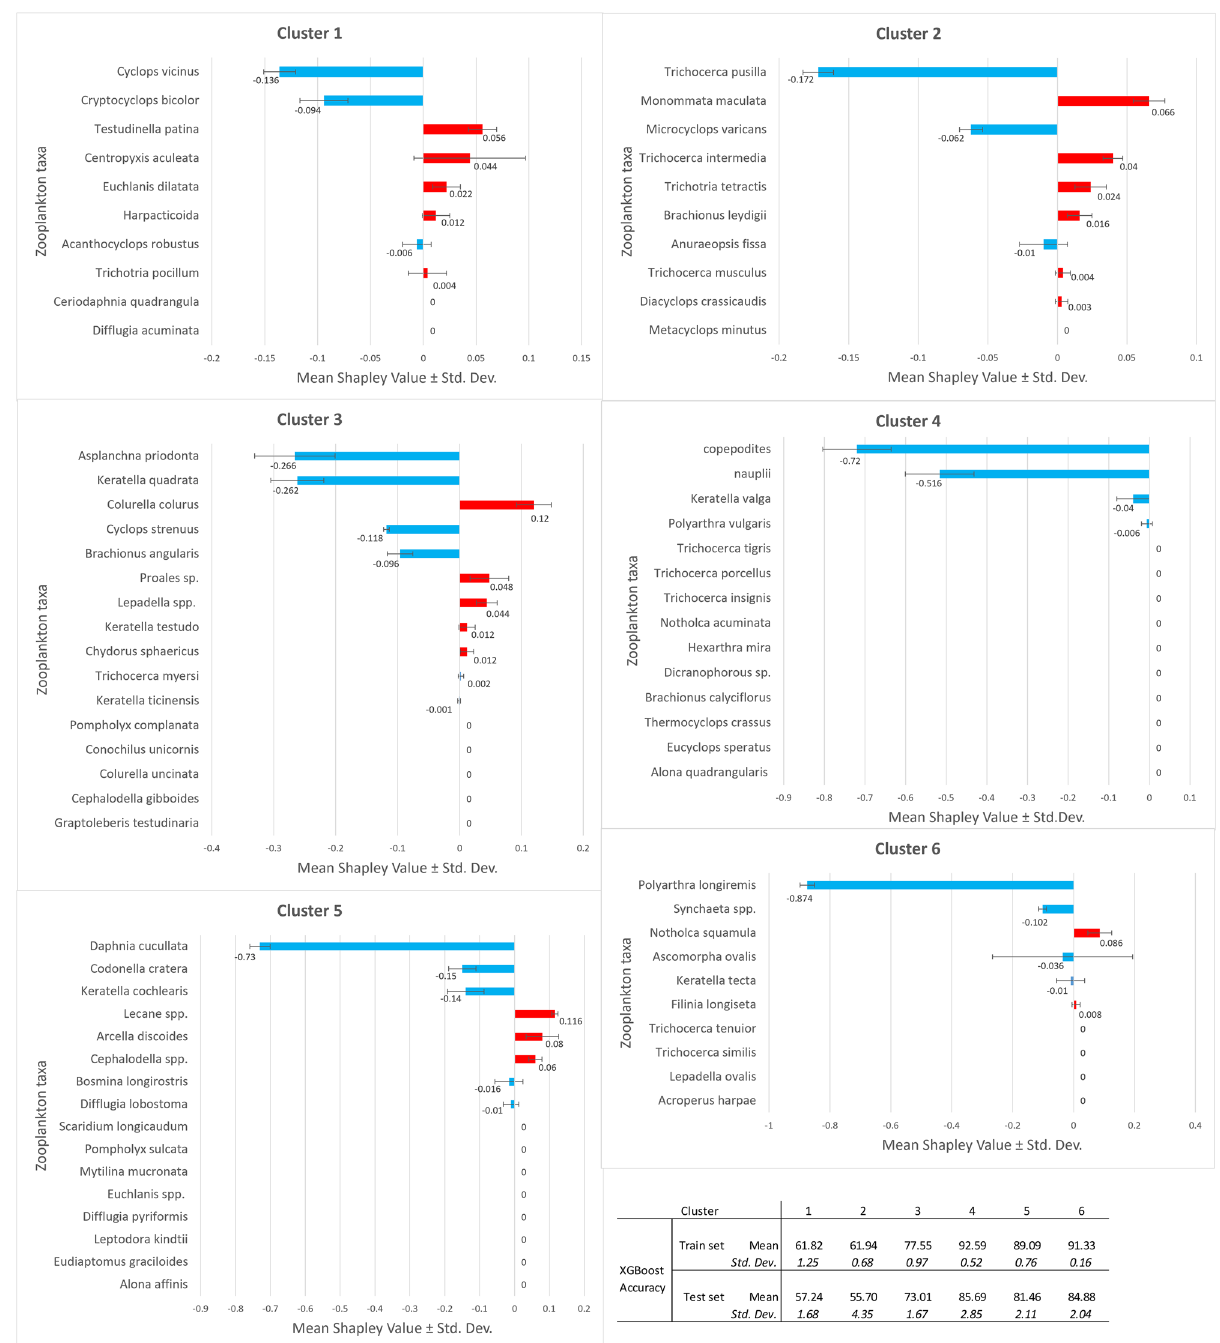
Figure 3. The SHAP has created six synthesis models for the response of zooplankton taxa to winter water warming. The models were built based on the cluster modelling results (Fig. 2). Each of the six SHAP cluster models shows the mean and standard deviation of five randomly selected individual SHAP modelling results. The values of the observations are shown: red bars and a positive Shapley value indicate higher biomass due to winter water warming, blue bars and a negative Shapley value indicate lower biomass. The table shows the mean and standard deviation of the five XGBoost models for each of the six SHAP cluster models. The distribution results of the individual SHAP models can be found in the Supplementary Information (Fig.